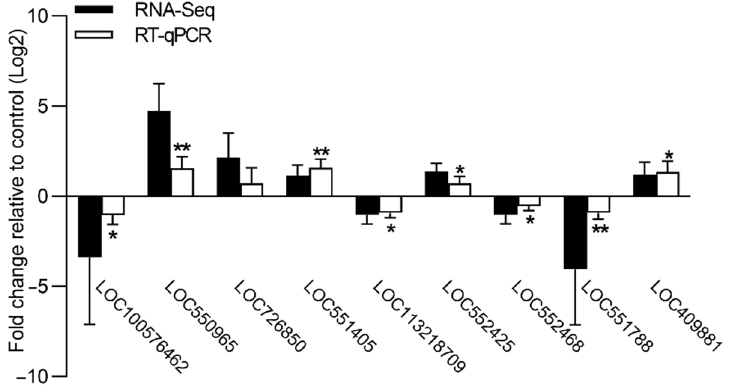
Figure 3. Validation of FPKM expression value (RNA-seq) for nine genes by RT-qPCR. The abscissa indicates the nine DEGs, and the ordinate indicates the relative expression levels of nine DEGs in the brains of the cadmium-exposed bees relative to the controls. The error bar indicates SD; the asterisk denotes significant differences (Student’s t-test, * p < 0.05; ** p < 0.01).